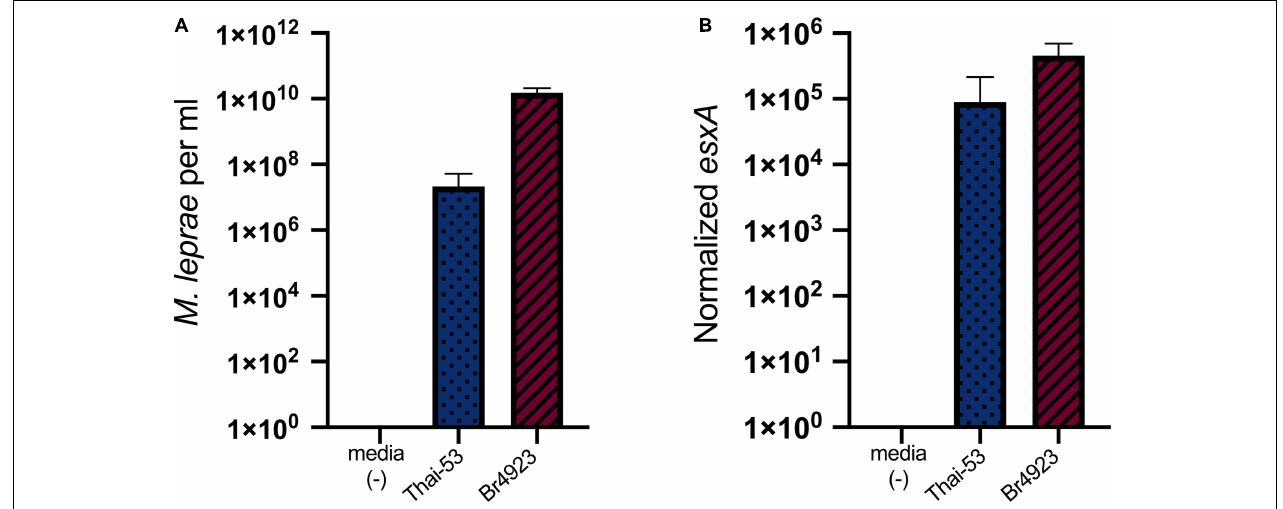
FIGURE 6 | Infectious nature of M. leprae after prolonged culture in tick cells. Mycobacterium leprae -infected cells maintained for over 300 days were purified and cell-free- M. leprae Thai-53 or Br4923 were injected into mouse. Uninfected media served as a negative infection control. After 6 months, M. leprae in footpad samples were analyzed by qPCR for bacterial load and viability. (A) Enumeration was accessed by qPCR of RLEP. (B) Mycobacterium leprae viability was determined by detecting esxA . Statistically significant differences ( p < 0.05) were analyzed by Mann-Whitney test when comparing between two strains.